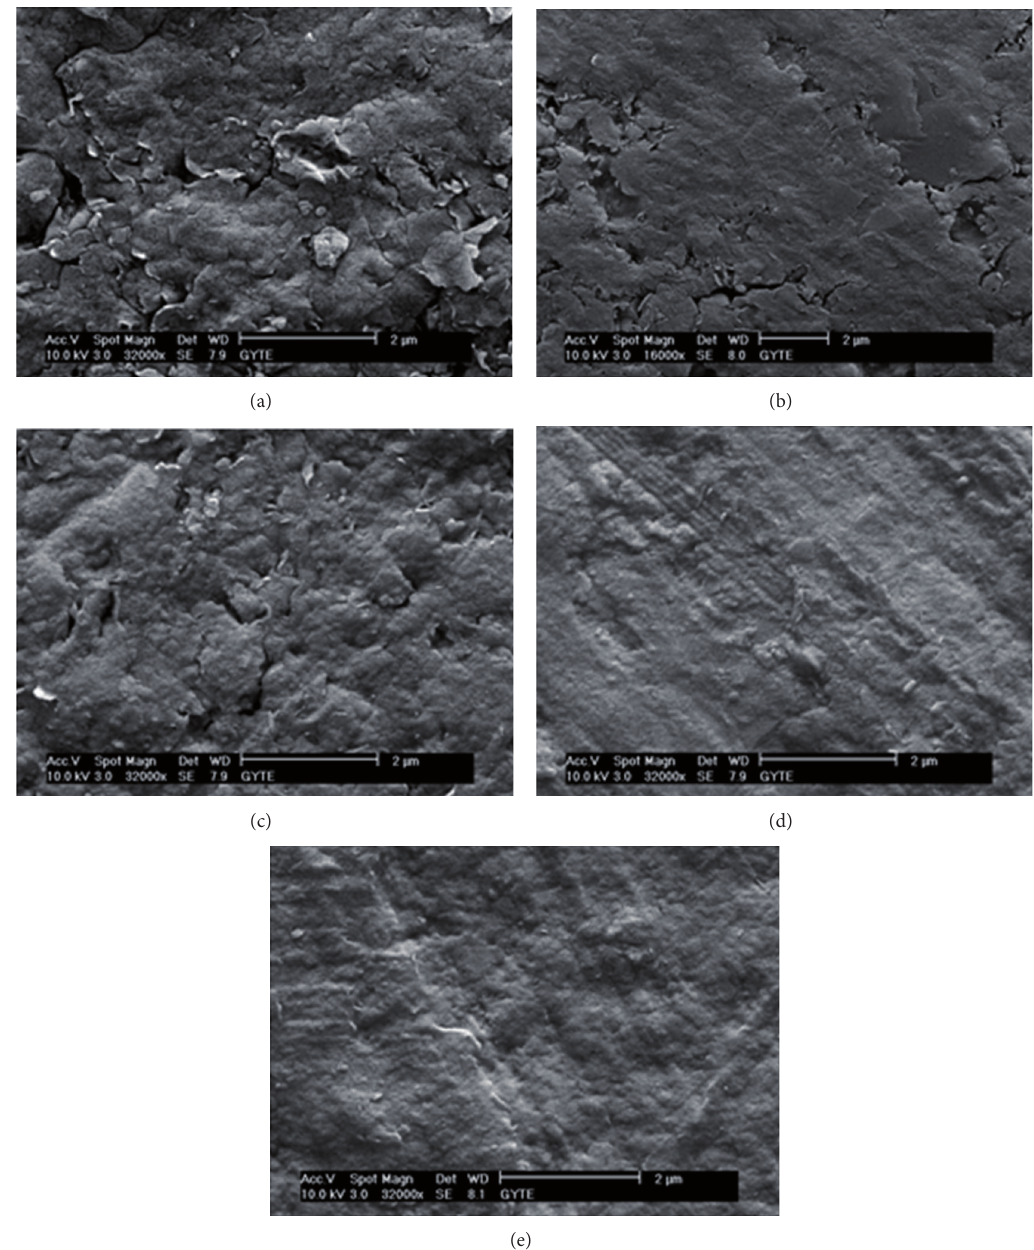
F 5: e SEM images of the pristine montmorillonite and the different organoclays (a) Mt, (b) 0.5 CEC-OMt, (c) 1.0CEC-OMt, (d) 1.5 CEC-OMt, (e) 2.0